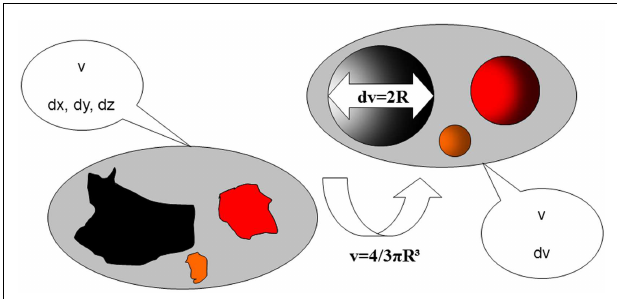
FIGURE 2 |The use of volume measurements compared to classical two-dimensional diameters of follicles . v , follicular volume; d x , d y , d z , follicular diameters in three planes; R , follicular radius (diameter/2); d v , reconstructed follicular